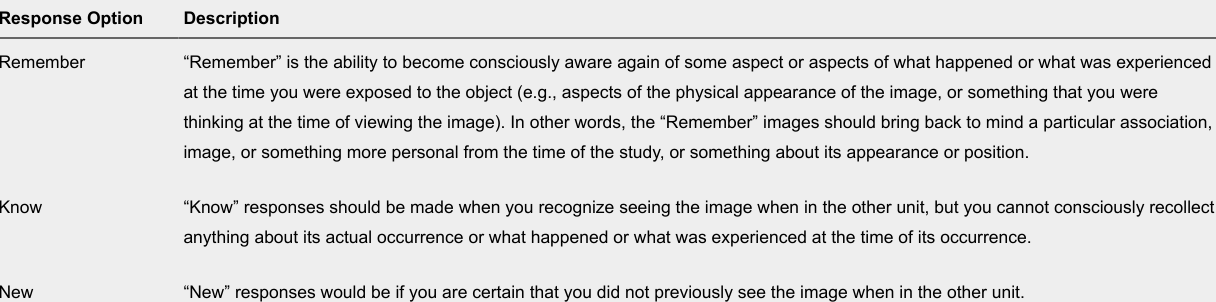
Response Options for the Implicit Recognition Memory Task (Experiment 3) Response